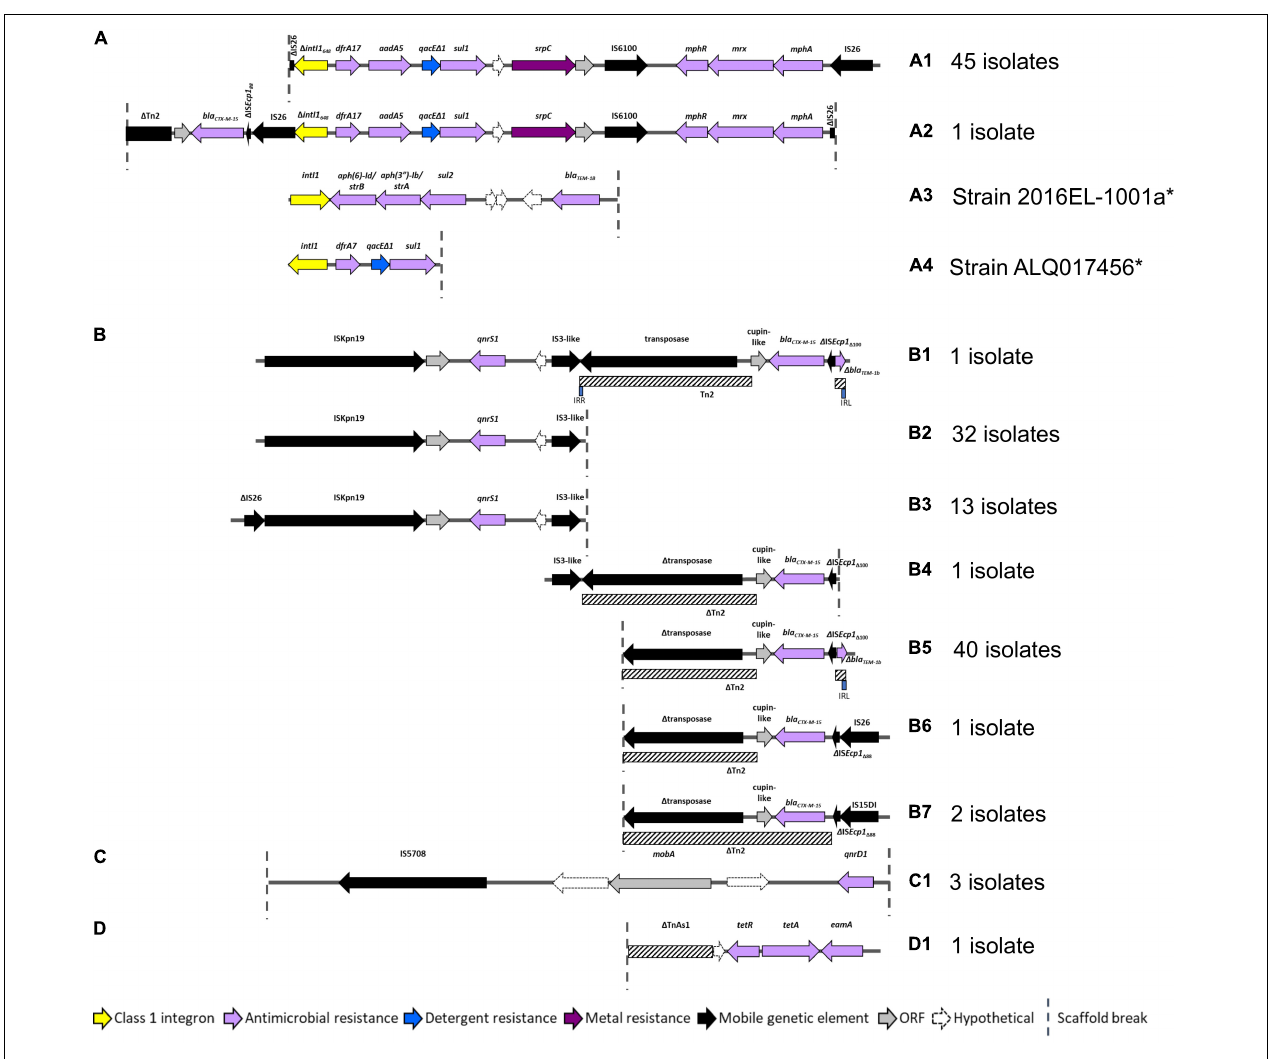
FIGURE 4 | AMR regions in ST182 isolates. (A) Structures containing class 1 integrons. *Two structures not from this collection but present in two other ST182 strains analysed in this study. (B) Structures containing bla CTX - M - 15 and/or qnrS1. (C) Structure carrying qnrD1 . (D) Structure containing